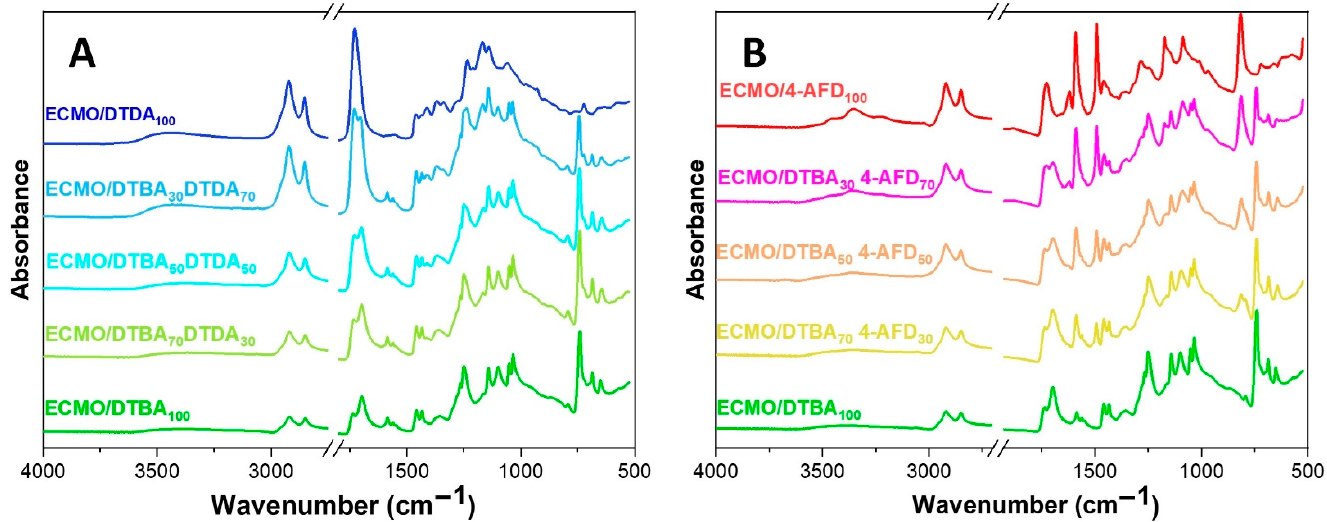
Figure 3. FT-IR spectra of the reactive groups in the uncured mixtures of ECMO/DTBA x DTDA y ( A ) and ECMO/DTBA x 4- AFD y ( B ).